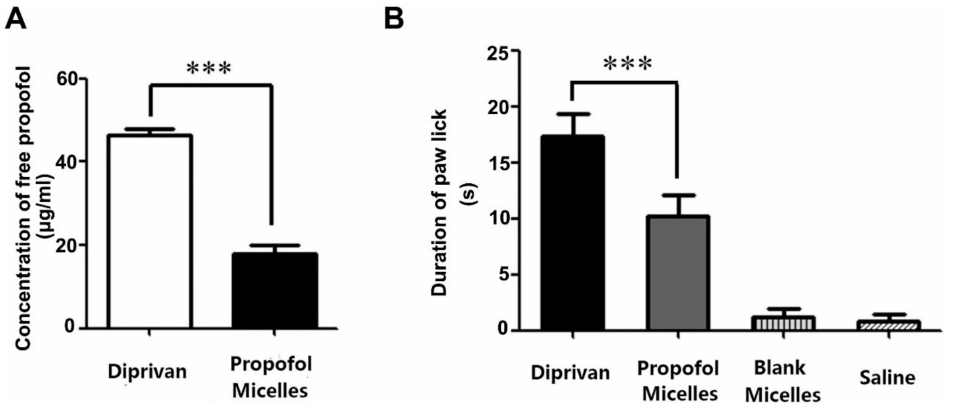
Figure 4. ( A ) Free propofol concentration in the aqueous phase of the mixed micelles and Diprivan (mean ± SD, n = 6). ( B ) Duration of rat paw-lick for propofol-mixed micelles and Diprivan ( n = 6; *** p < 0.001).